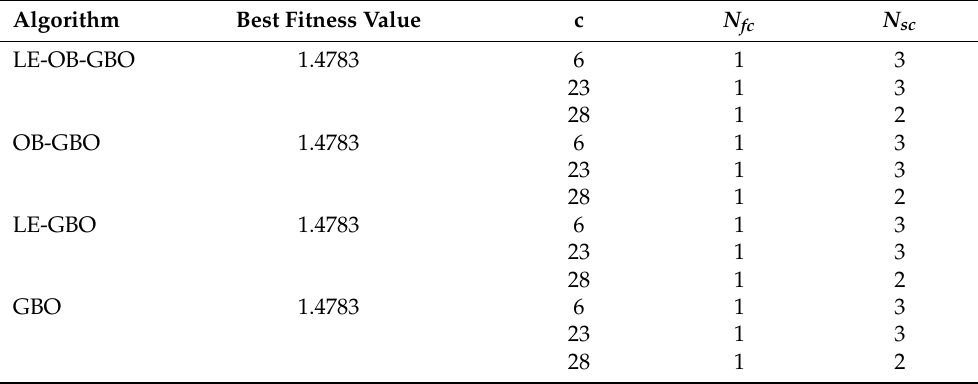
Table 6. Optimal placement of the charging station—case Table 5. Optimal placement of the charging station — case 1.